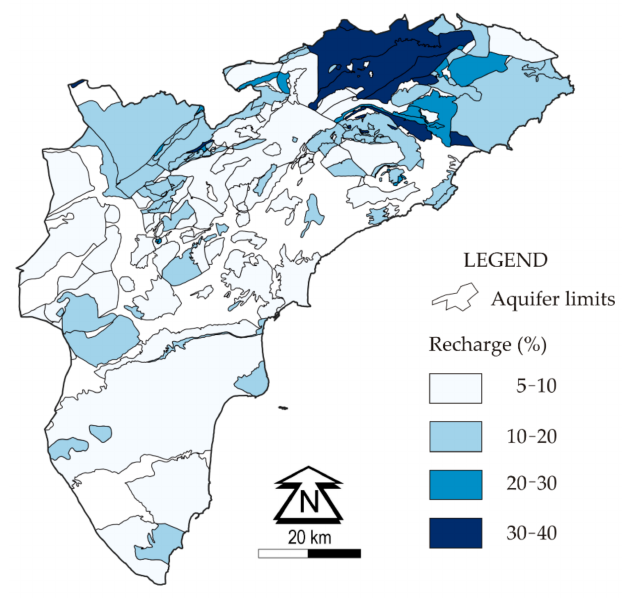
Figure 11. Distribution of recharge rates for aquifers of Alicante.